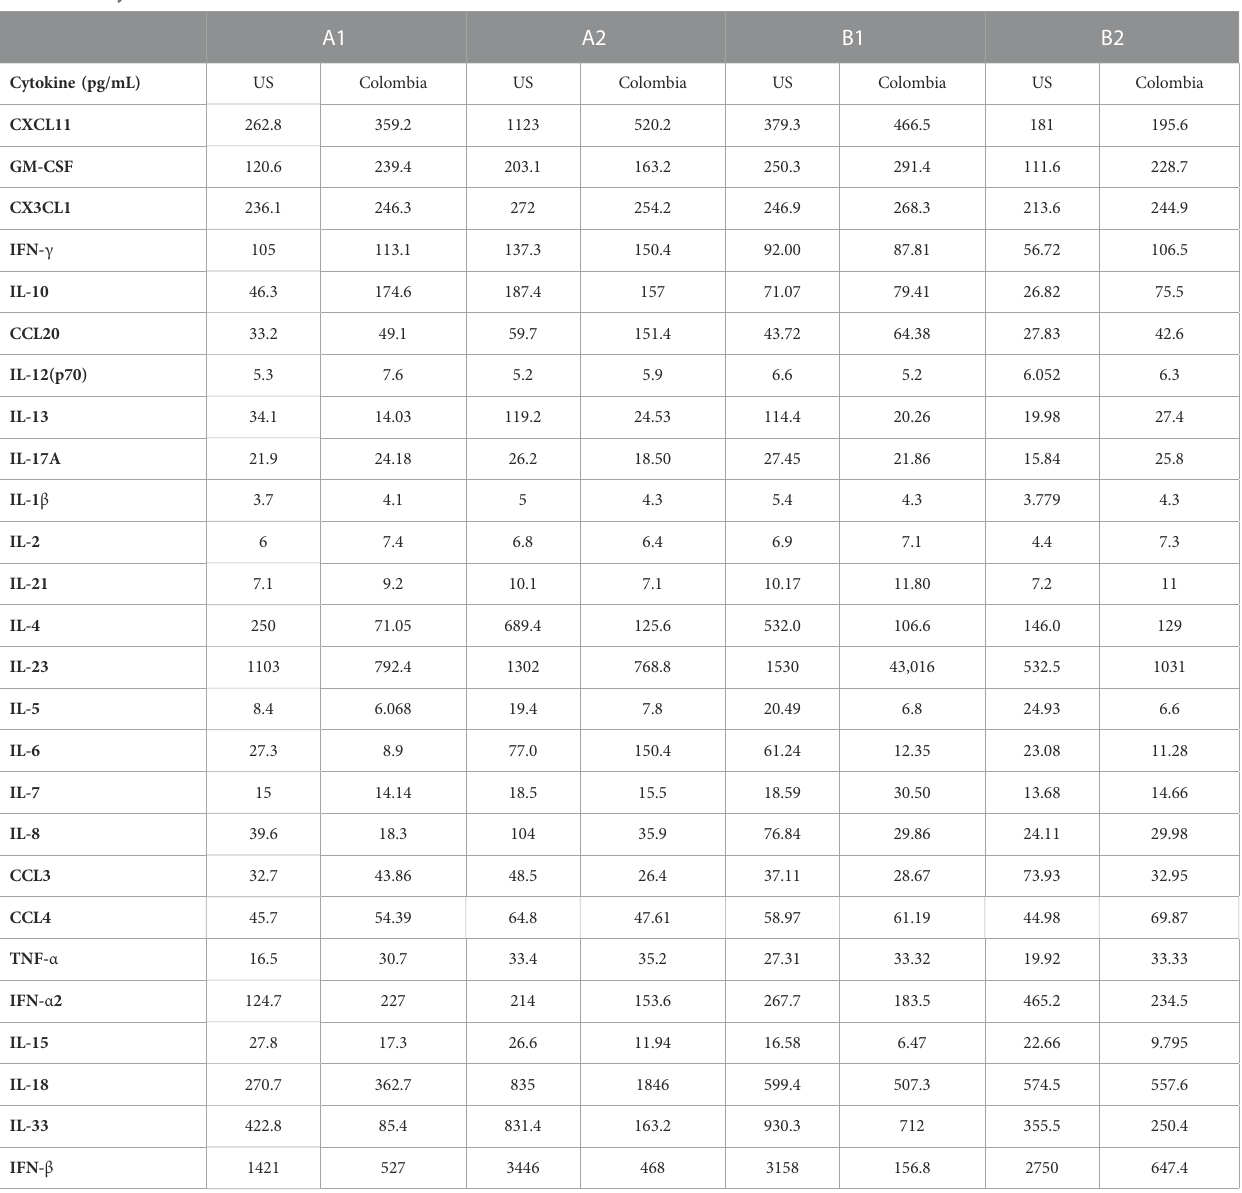
TABLE 2 MIA Cytokine levels US vs.